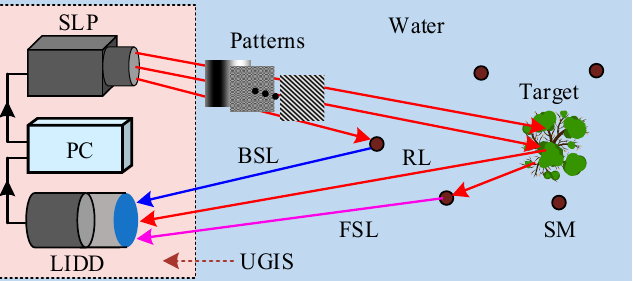
Figure 1. Schematic diagram of the UGIS model, RL: reflective light. The PC first controls the SLP to send structured illumination patterns onto the target, then controls the LIDD to record the light intensity, and finally restores the target image. The noises in this model mainly come from the BSL and FSL.